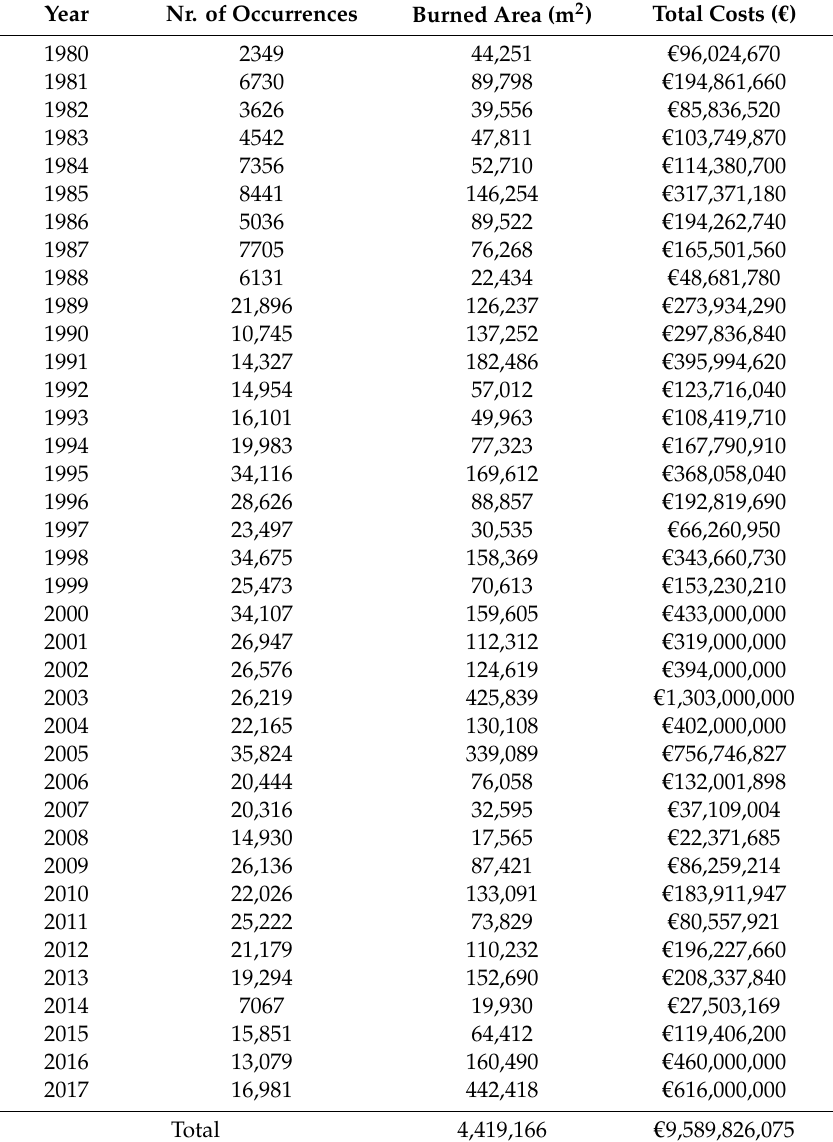
Table 2. Annual costs associated with rural fires (adapted from [20] and